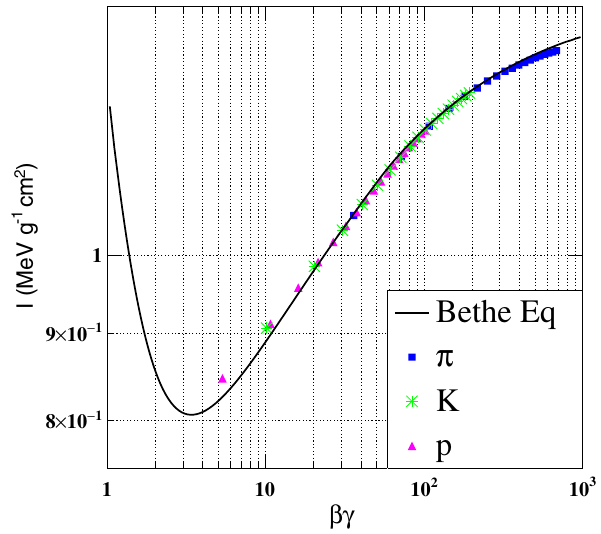
MC result of single-particle events with the theoretical prediction by the Bethe equation [16] overlaid. In the right plot the dots are from simulation of e + e − → Z → q ¯ q